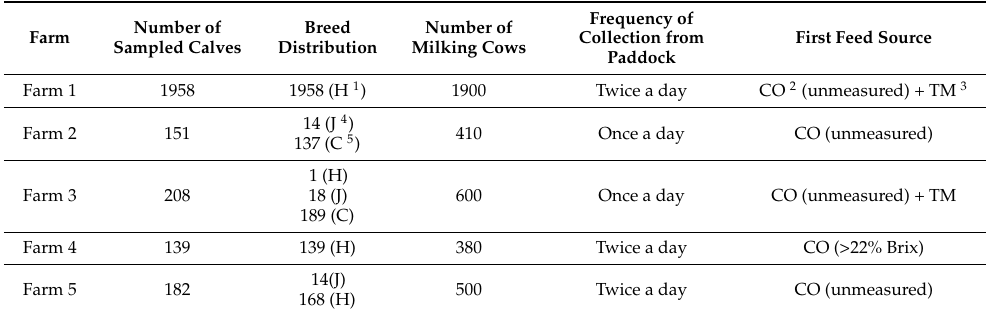
Table 2. Description of dairy farm management and study population. All calves sampled at 1–7 days of